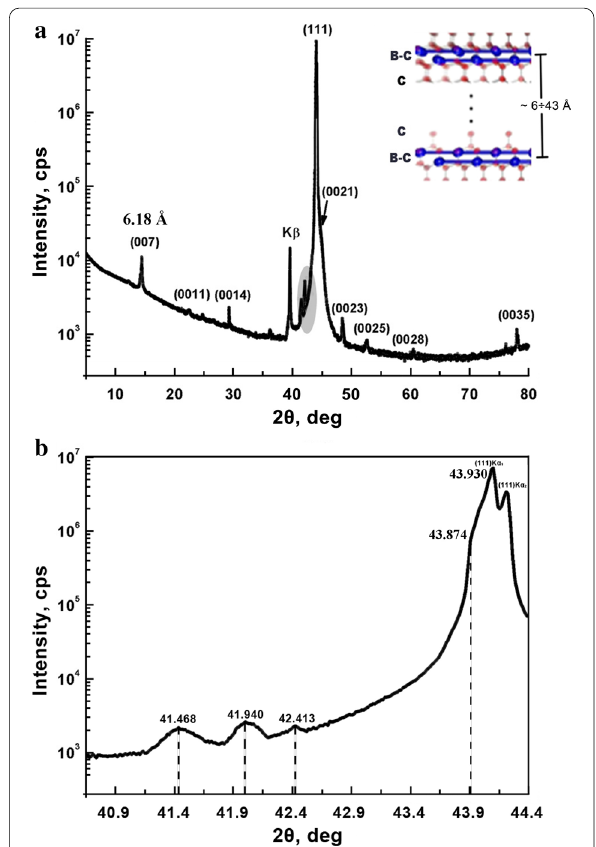
Fig. 8 a X-ray diffraction pattern (θ/2θ-scan) of the single-crystal BDD plate with the (111) surface orientation. The inset (top right) shows the layout of boron–carbon layers in a cubic diamond matrix with distances between them from ~ 6 to 43 Å. b Part of the diffractogram a containing the area marked with gray color in an enlarged